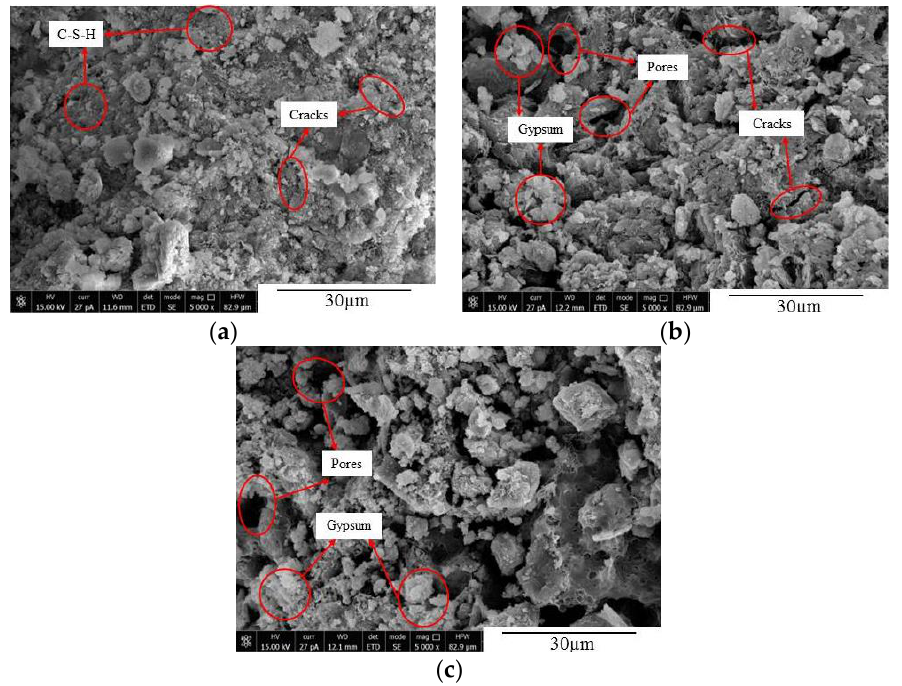
Figure 14. Microcrack expansion of FA20 concrete at different corrosion times. ( a ) FA20-D0; ( b ) FA20-D90; and ( c ) FA20-D150.